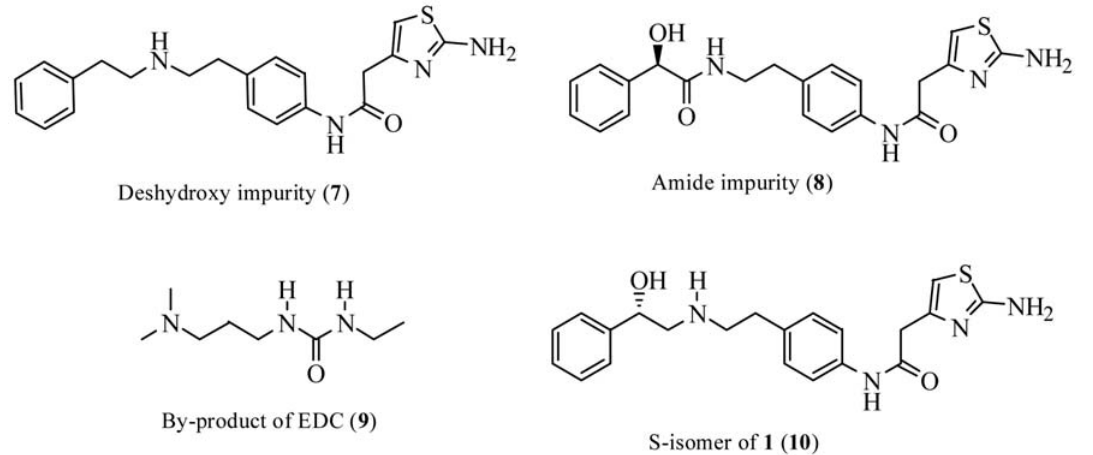
Figure 1. Process related impurities.